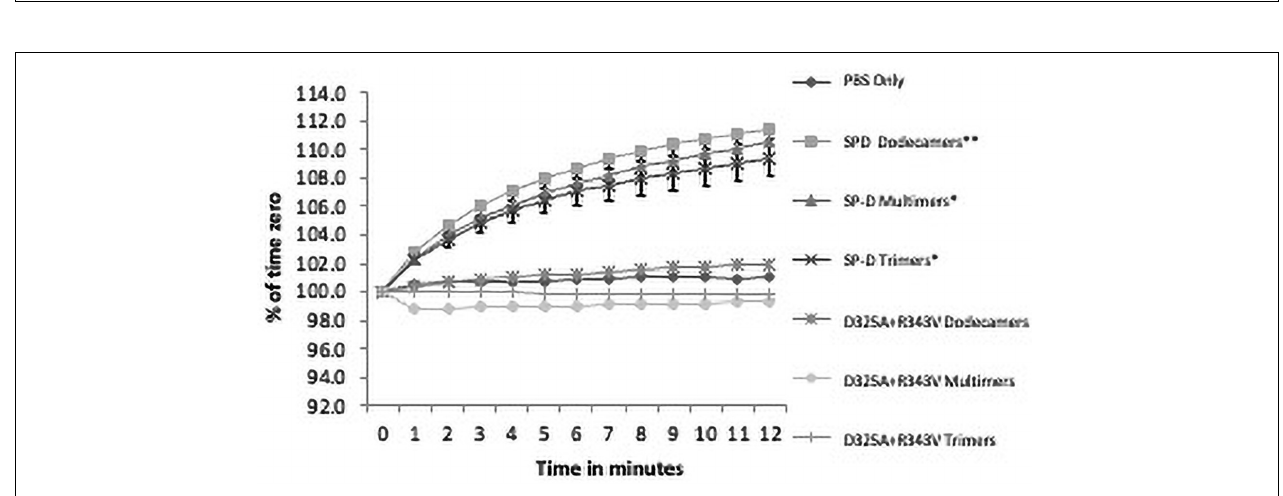
FIGURE 1 | Mouse survival after infection with Cal09 H1N1 influenza A virus (IAV). The viral inoculum was instilled along with the D325A + R343V mutant surfactant protein D (SP-D) neck and carbohydrate recognition domain (NCRD) (D325A + R343V), wild-type SP-D NCRD (NCRD), or an equal quantity of PBS (Cal09 virus alone). There were no differences in mortality among the groups. The methodology for these experiments is outlined below the figures.